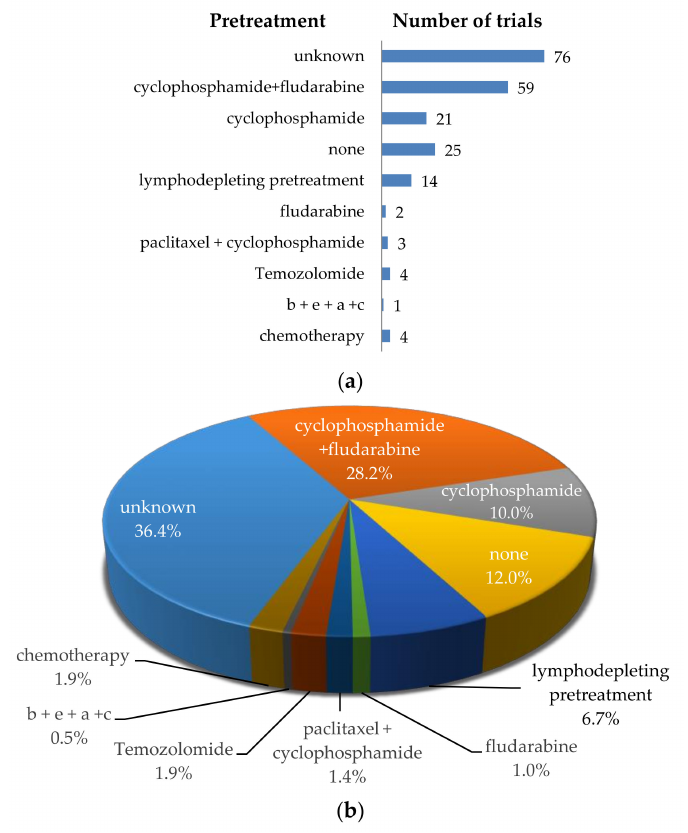
Figure 8. Schematic overview of the pretreatments used before CAR-T cells were applied in patients. ( a ) Number of clinical trials using a specific pretreatment; ( b ) Proportional distribution of clinical trials per pretreatment. Data was extracted from